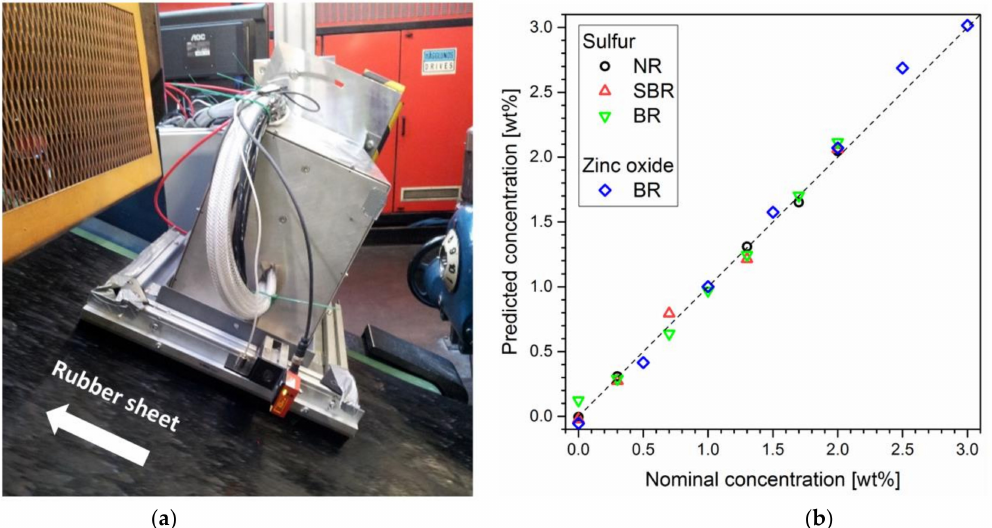
Figure 16. LIBS in-line measurement of tire rubber. ( a ) Photograph of the LIBS system installed at the tire rubber production line. ( b ) Validation of S and ZnO concentrations measured in different types of rubbers (dashed line: ideal match). Adapted from